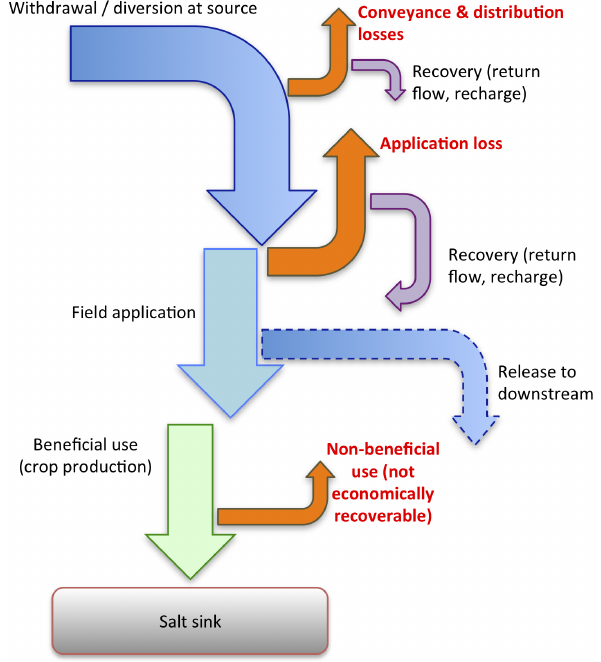
Fig. 1. Irrigation efficiency, loss/depletion, and